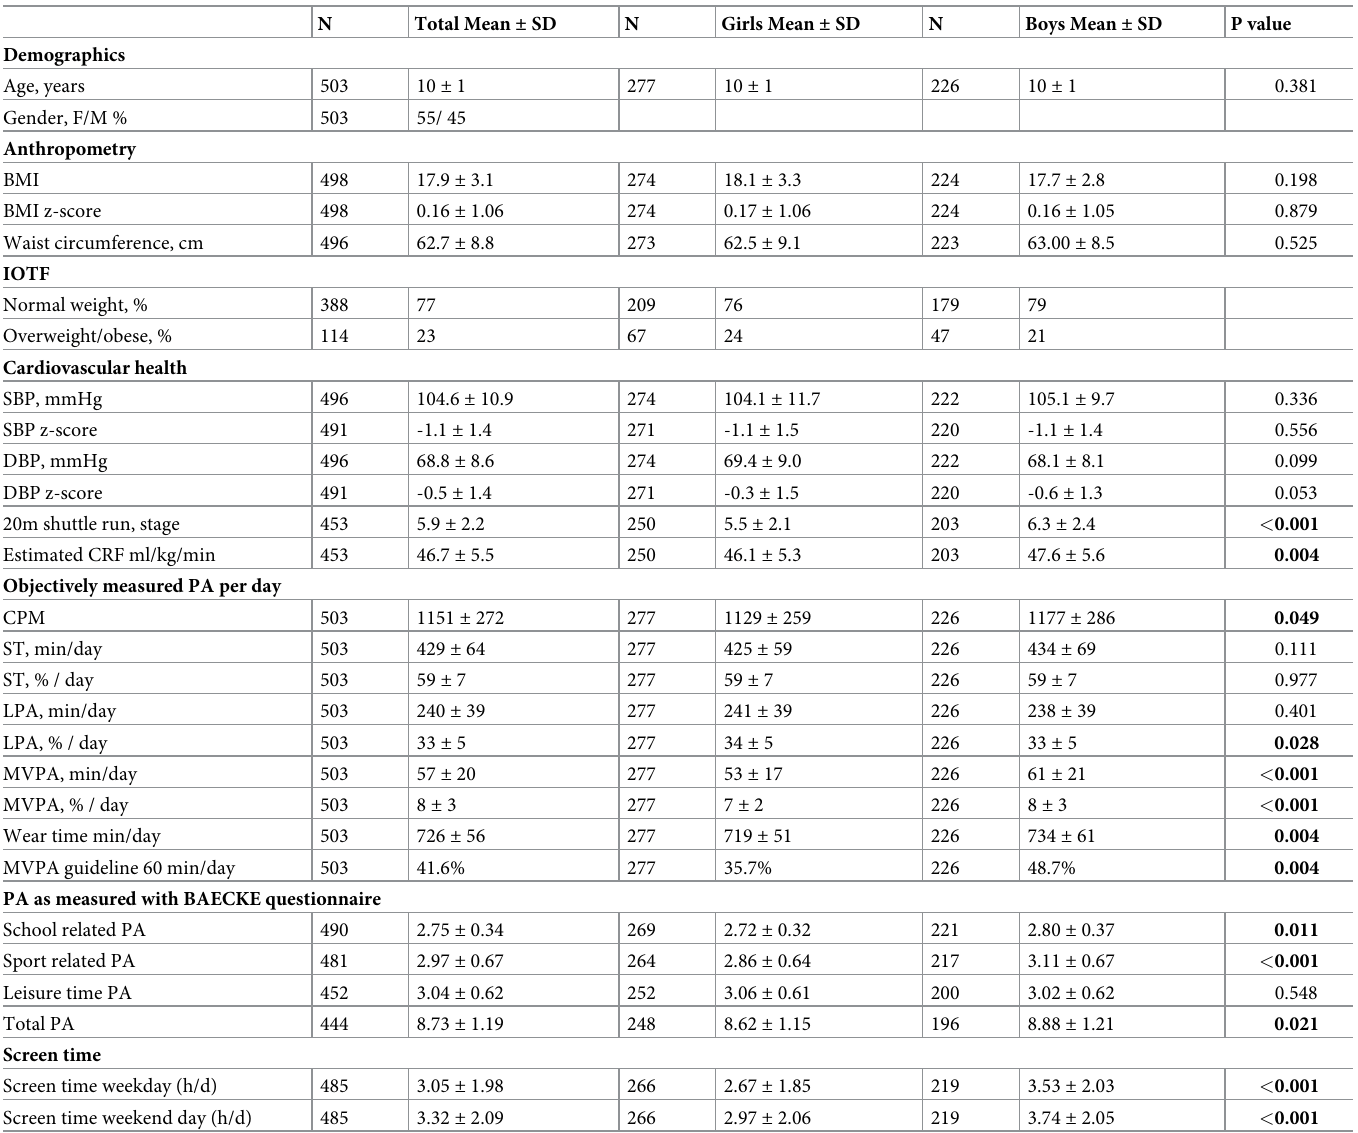
Table 1. Participant